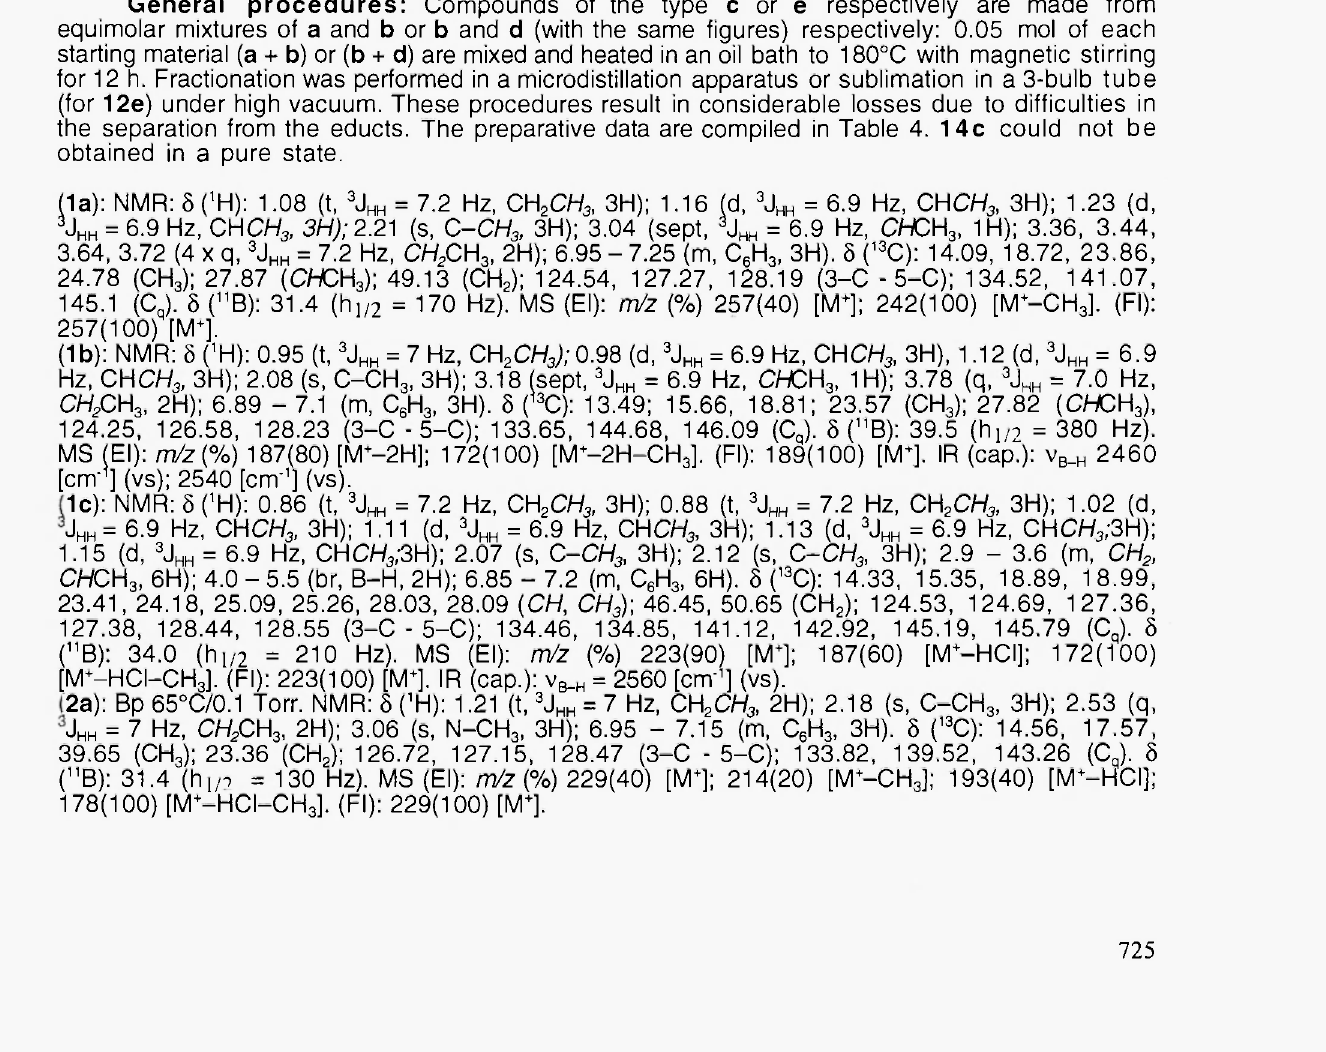
amino(dichloro)borane dissolved in 200 ml toluene is added dropwise at 0°C. The reaction mixture is refluxed during 12 h and then filtered from the precipitate. The toluene is distilled off. The remaining liquids are fractionated in a microdistillation apparatus.